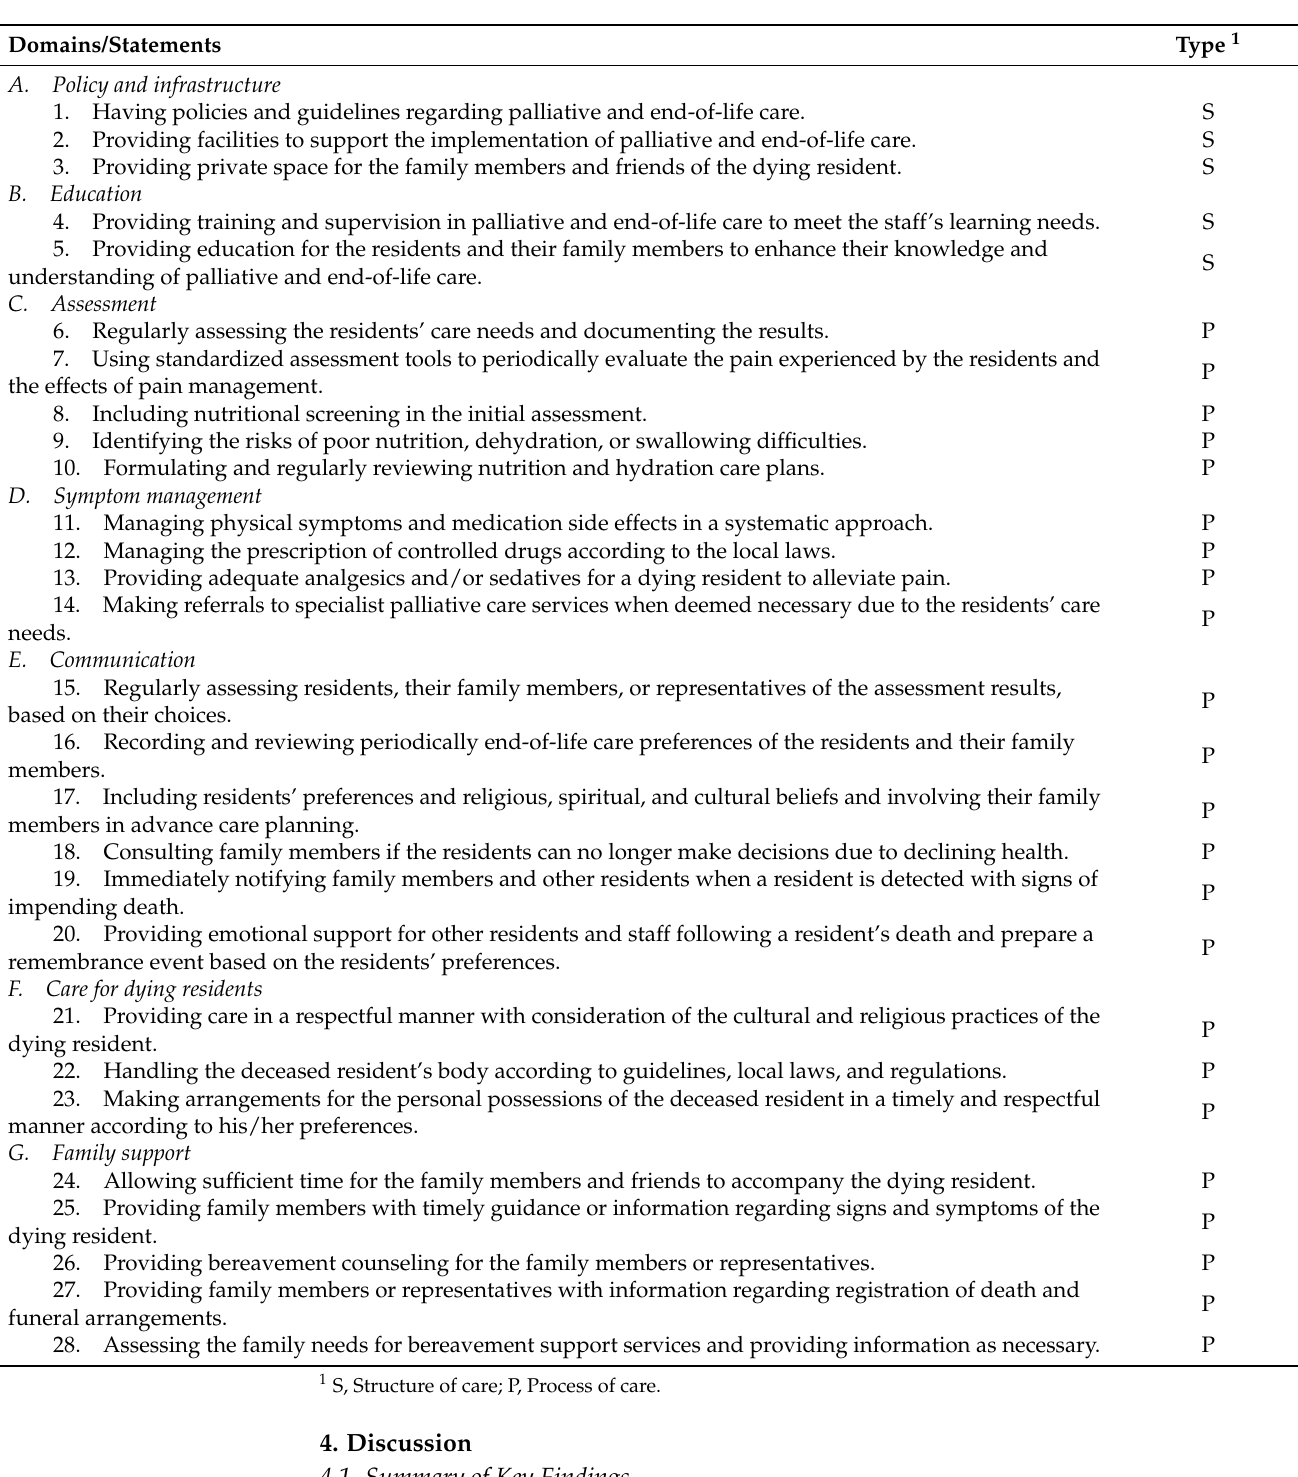
Table 2. Finalized list of